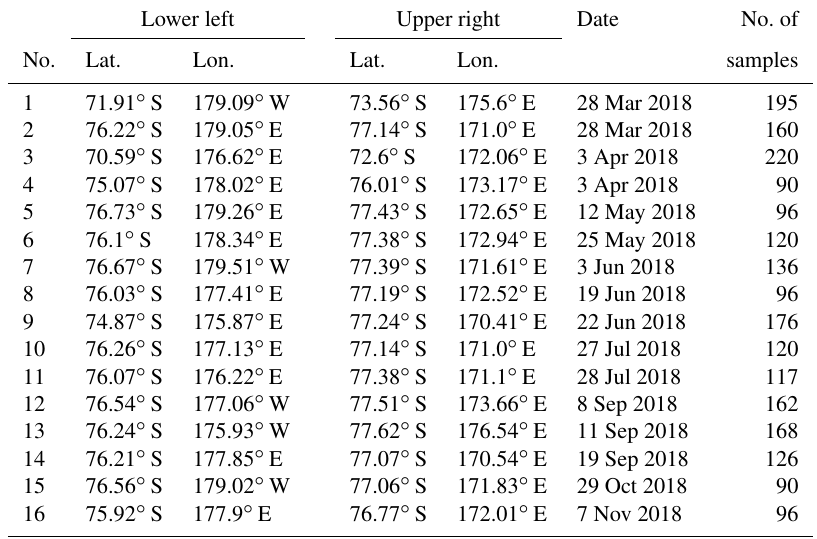
Table A1. Sampling areas for YI in the western Ross Sea. Note: Lat. = latitude, Lon. = longitude, No. = number. Lower left Upper right Date No. of No. Lat. Lon. Lat. Lon. samples